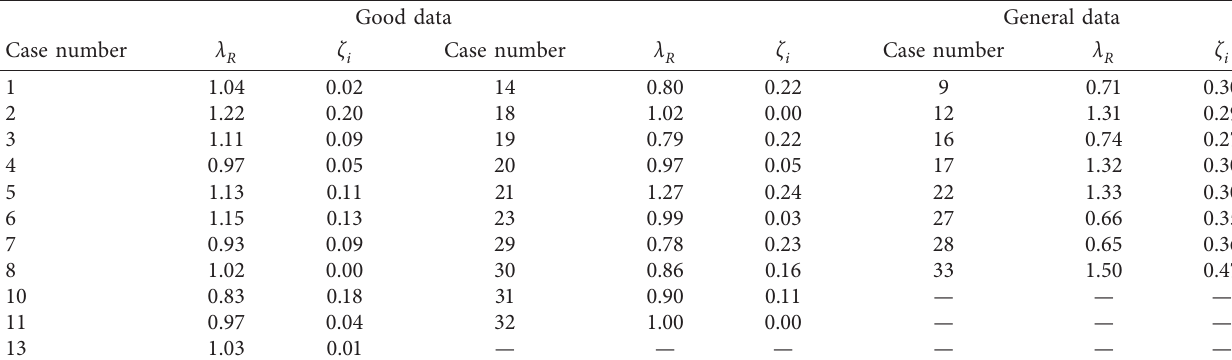
Figure 2: The scatter diagram of testing pile capacity and calculation pile capacity. Table 3: Classified results of load test data in noncohesive